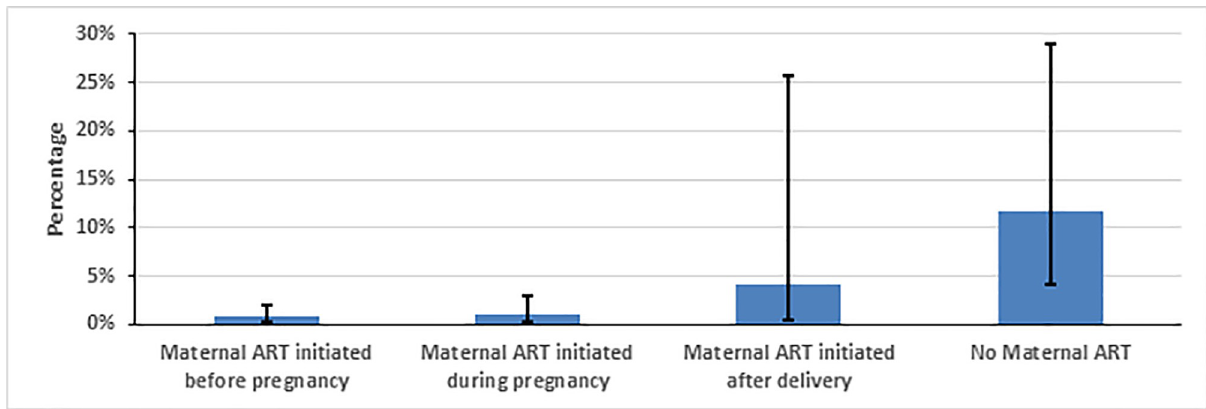
Fig 2. Weighted early mother to child transmission of HIV measured at 4–12 weeks post-partum by maternal ART initiation time, Namibia,